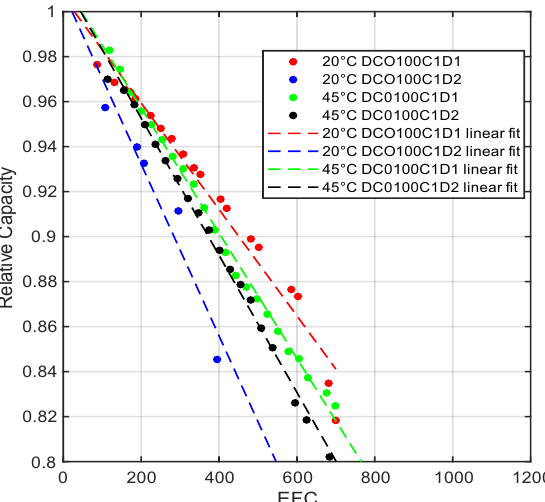
Figure 1. Degradation phenomena as the loss of capacity per cycle [28] (DCO stands for Depth of discharge, C is the charge rate and D is the discharge rate).